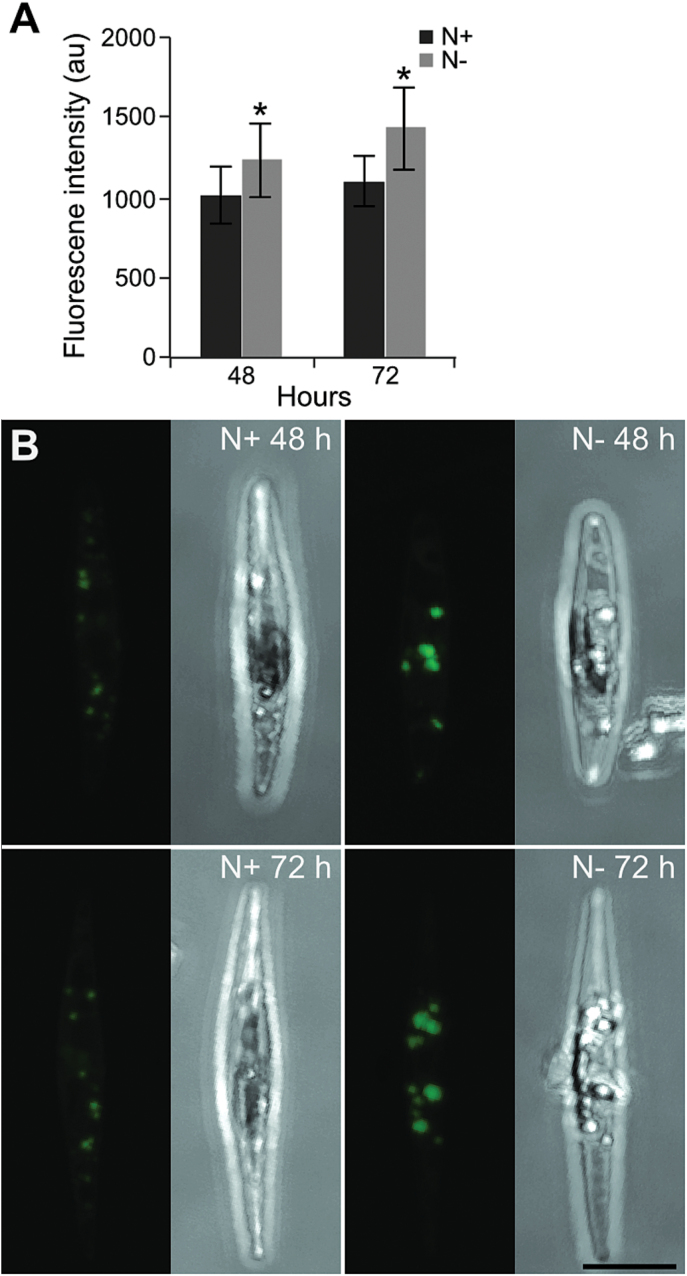
Accumulation of neutral lipids during nitrate deprivation. (A) Fluorescence intensity in P. tricornutum cells stained with BODIPY 505/515 at 48 and 72h after N deprivation. The level of lipid fluorescence was measured in 20–30 randomly selected cells using confocal microscopy. Statistical differences (*P<0.01) between nitrate-replete (N+) and nitrate deprived (N–) cultures are indicated. au, Arbitrary units. (B) Z-stack projections of P. tricornutum in N+ and N– cultures at 48 and 72h after N deprivation. Bar, 5 μm. (This figure is available in colour at JXB online.)